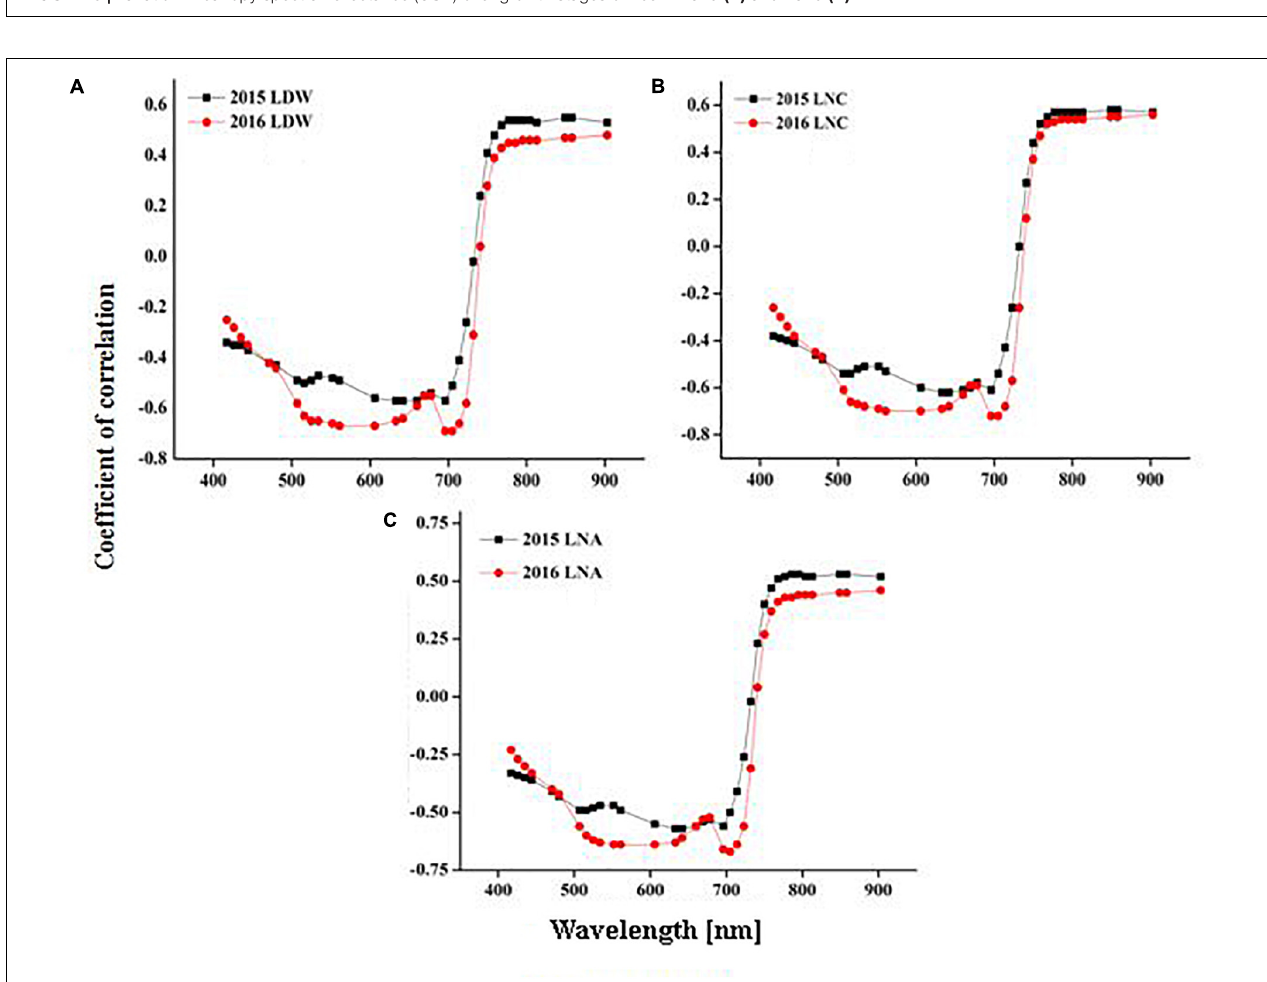
FIGURE 4 | Coefficient of correlation between leaf nitrogen status indicators [LDW, (A) , LNC, (B) and LNA, (C) ] and CSR over rice growth in 2015 and 2016.